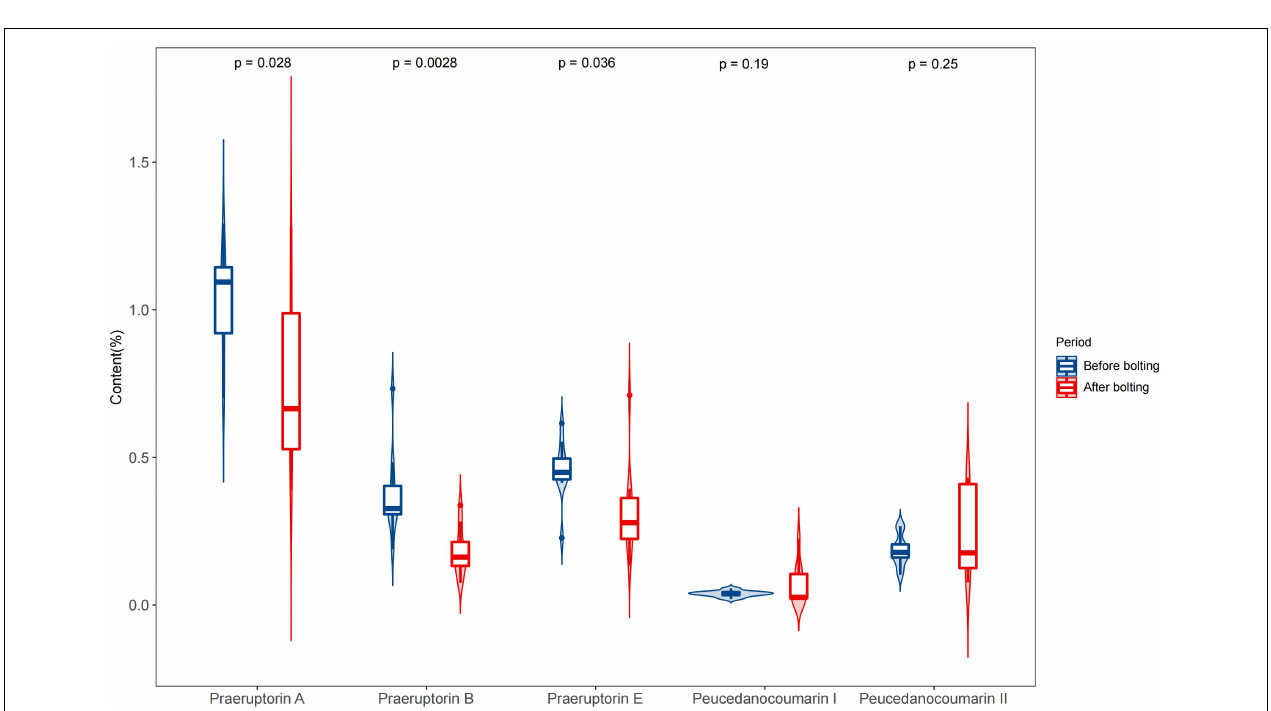
FIGURE 3 | The chemical structure and high performance liquid chromatograms of five coumarin components. (A) The structures of the coumarins, (B) The liquid chromatogram of the standards, (C) The liquid chromatogram of test sample. Numbers one to five depict peucedanocoumarin I, praeruptorin A, peucedanocoumarin II, praeruptorin B, and praeruptorin E, respectively.